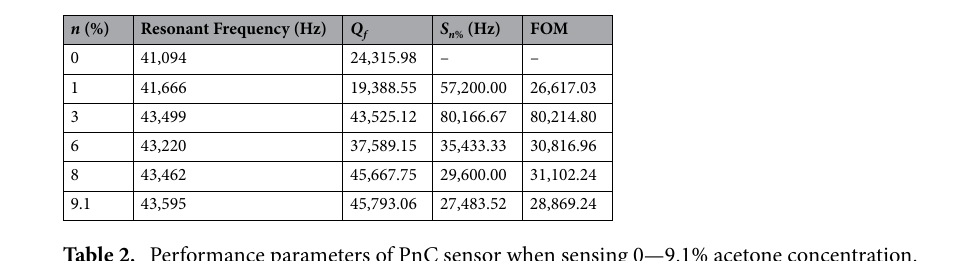
Table 2. Performance parameters of PnC sensor when sensing 0—9.1% acetone concentration.